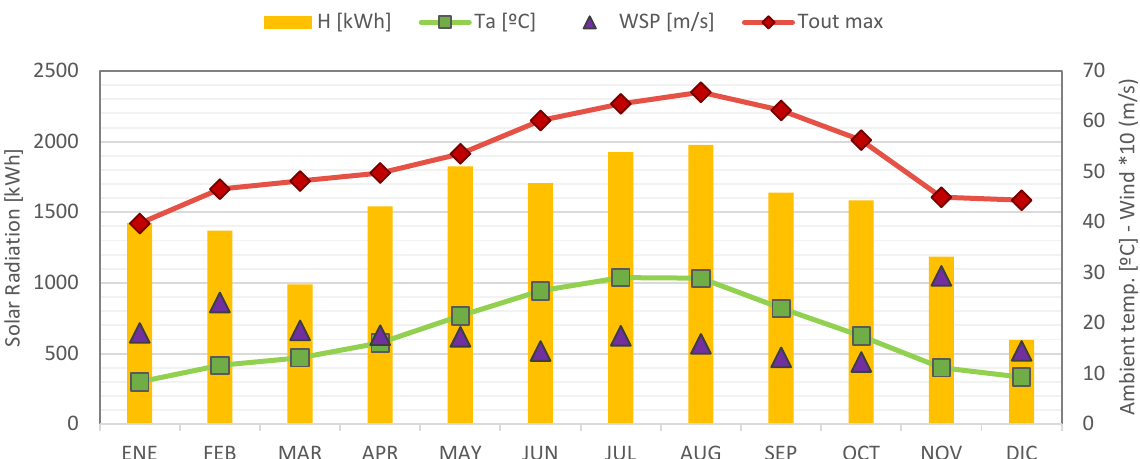
Figure 6. Monthly distribution of energy production and average efficiencies.